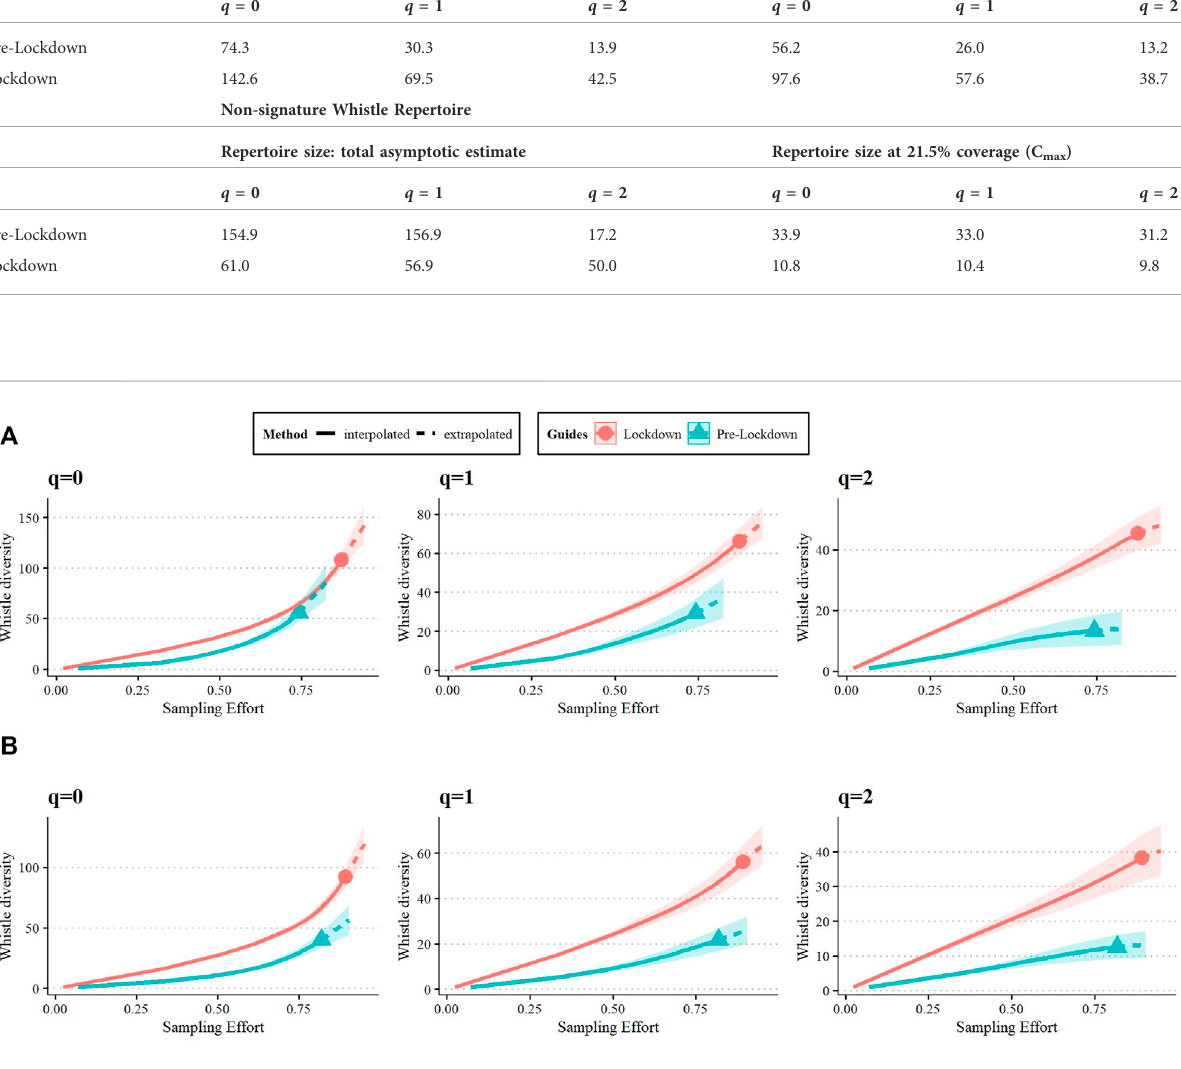
FIGURE 4 Coverage-based rarefaction/extrapolation curve of whistle diversity for each Hill number determined for the full (A) and signature whistle (B) . The curve represents both interpolated (solid) and extrapolated (dashed) estimates with a con fi dence interval of 95%.